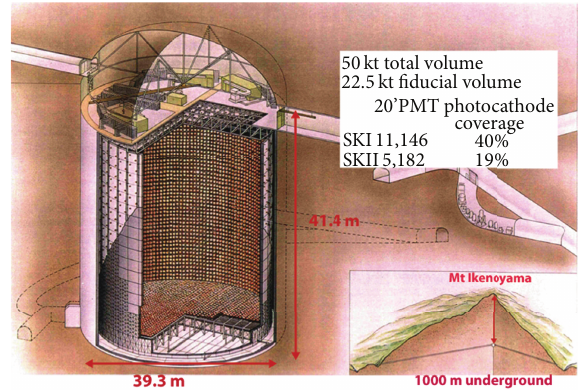
Figure 7: Global view of the SK